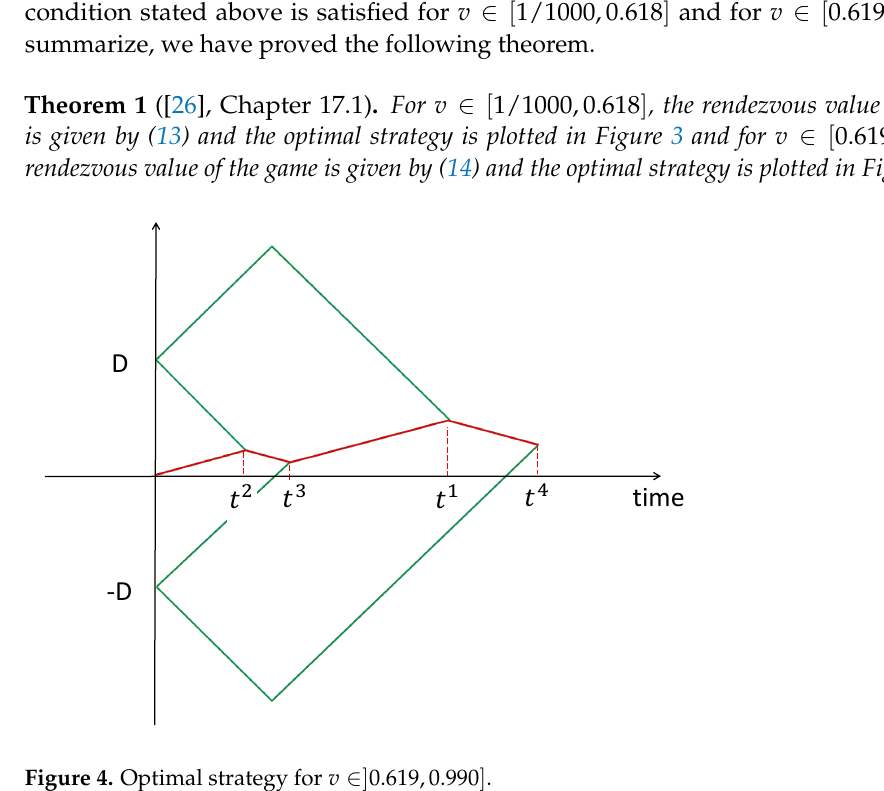
Figure 4. Optimal strategy for v ∈ ] 0.619,0.990 ]